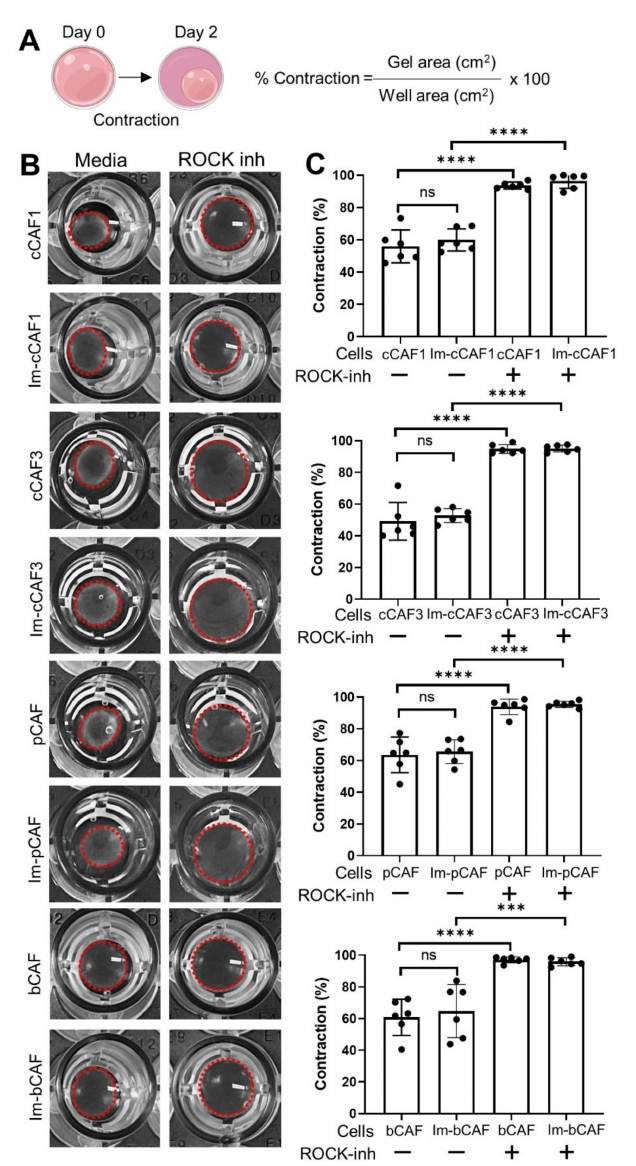
Figure 5. Immortalized CAFs are contractile. Primary CAFs and immortalized CAFs were seeded into a collagen gel with or without Rho-associated protein kinase (ROCK) inhibitor (100 mM) for 48 h. ( A ). Schematic representation of gel remodeling. Gels were detached, the gel contraction was digitally photo-documented, and % contraction calculated as shown. ( B ). Contraction was measured as a % reduction of gel surface after 48 h. ( C ). Pooled data representing mean values ± SD of 6 replicates from 2 independent experiments. Primary cells were evaluated at passage 3; immortalized cells at passage 4–5. One-way ANOVA, ns: non-significant, *** p < 0.001, **** p <